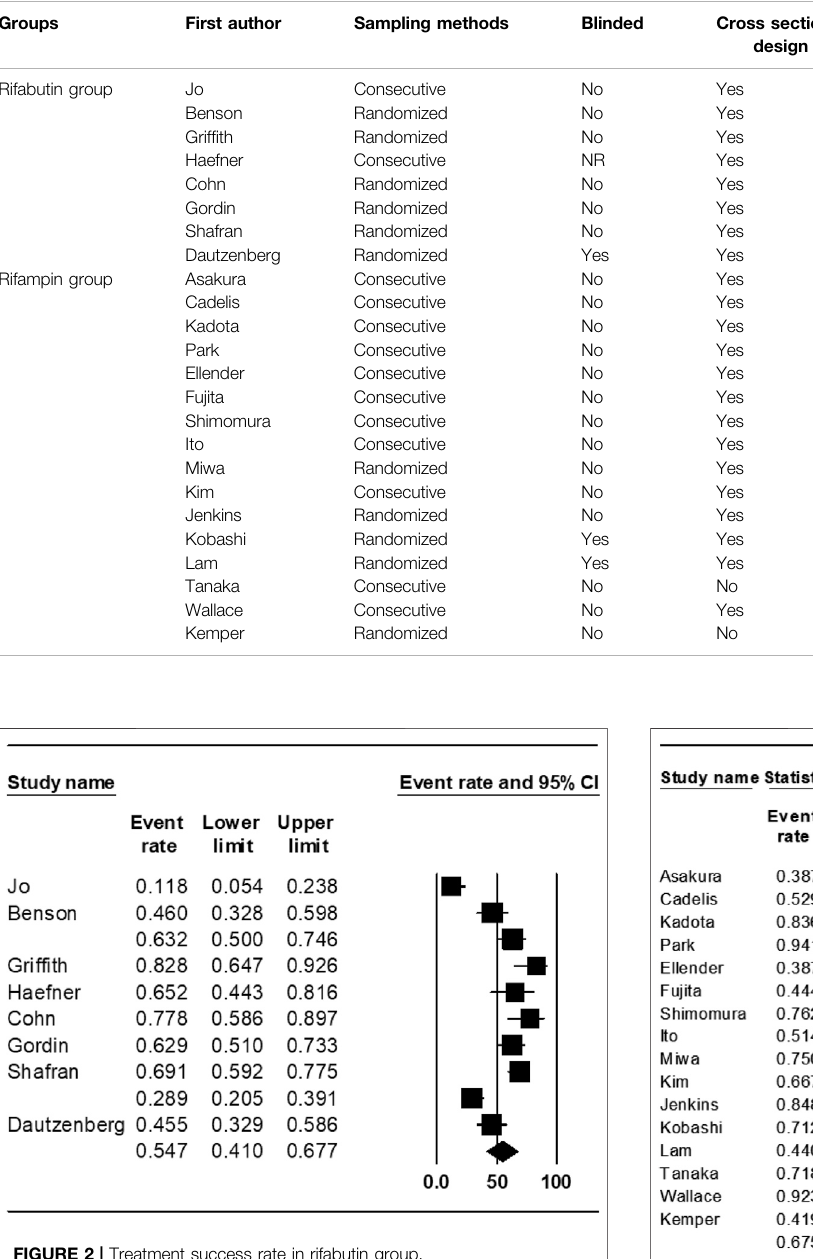
TABLE 2 | Assessment of study quality.